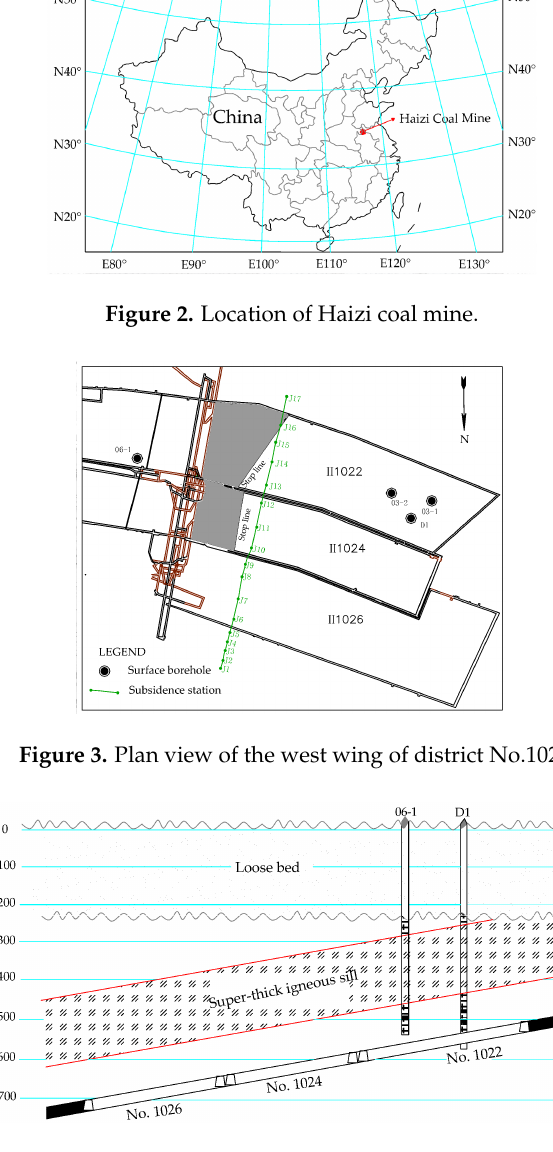
Figure 4. Cross-sectional view of the west wing of the district